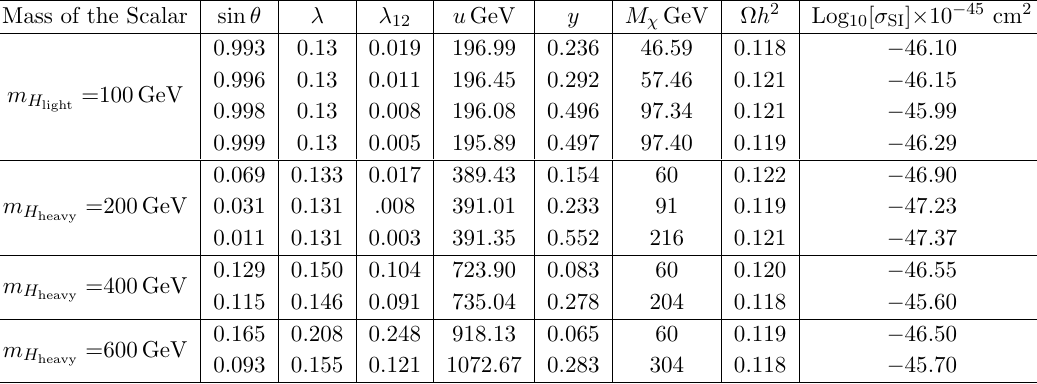
Table 6 . Some characteristic benchmark points for the model in both low and high mass regions satisfying dark matter relic density and direct search constraints.